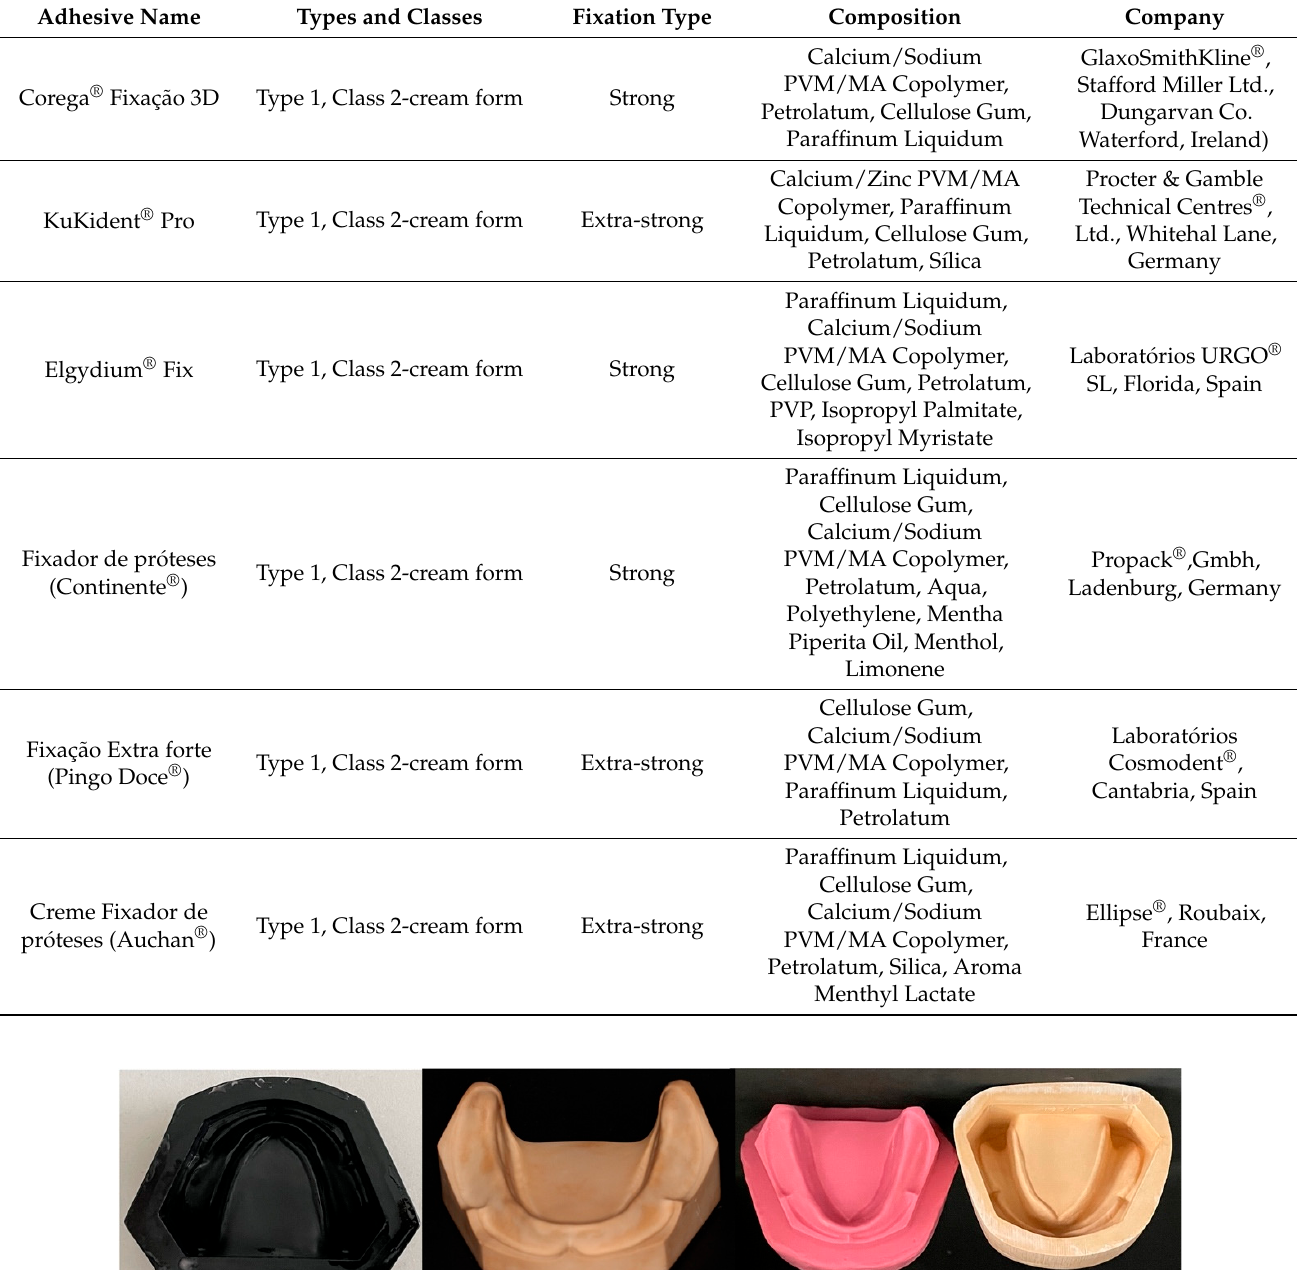
Table 1. Denture adhesives used.